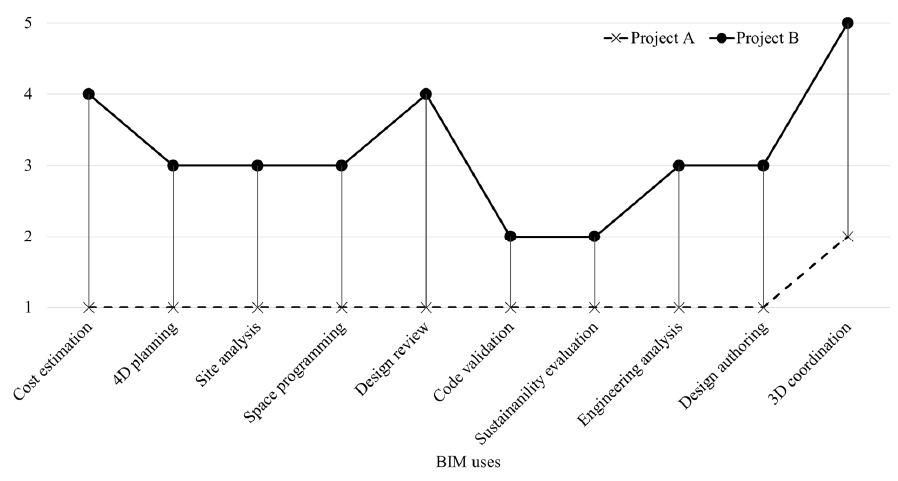
Figure 1. BIM uses assessment: Project A and project B.